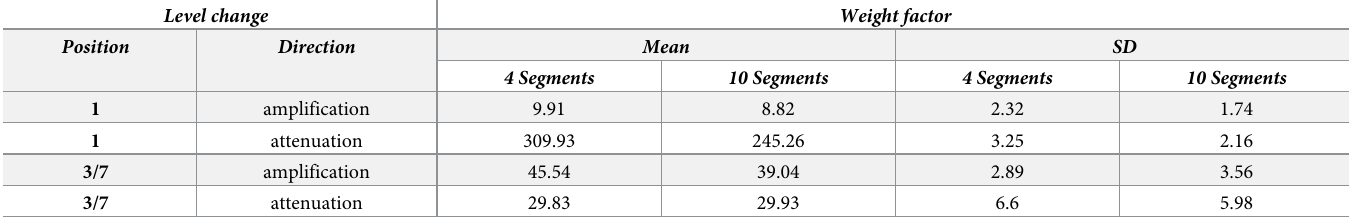
Table 4. Experiment 2. Geometric means and standard deviations of the weight factors for the different positions and directions of level change, separately for the four- and ten-segment sounds. Level change